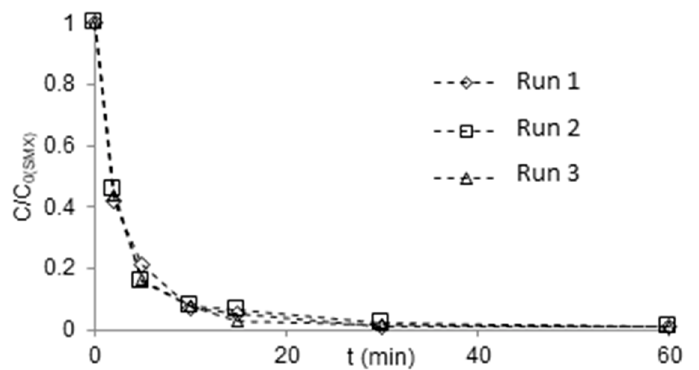
Figure 6. Dimensionless SMX concentration during reproducibility runs of photocatalytic ozonation with H 2 O 2 (L / O 3 / H 2 O 2 ) in the presence of